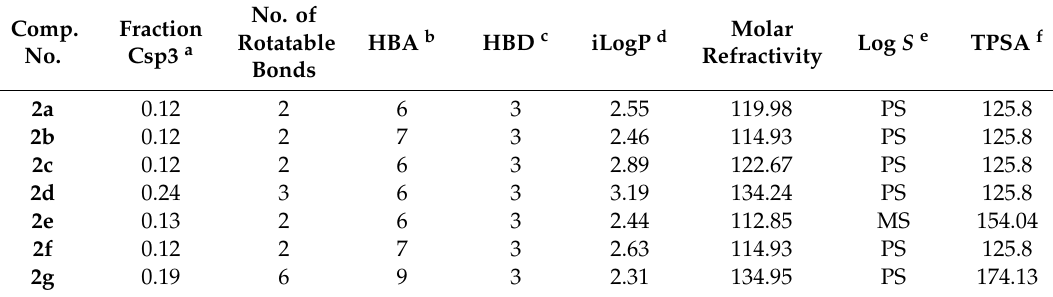
Table 2. Physicochemical properties of the selected compounds 2a – 2g .